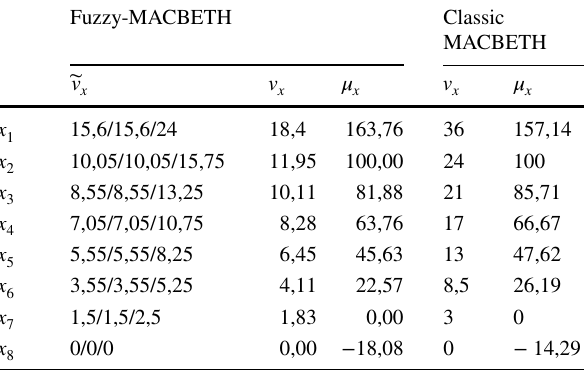
Table 7 Results of the Fuzzy-MACBETH method for the second example